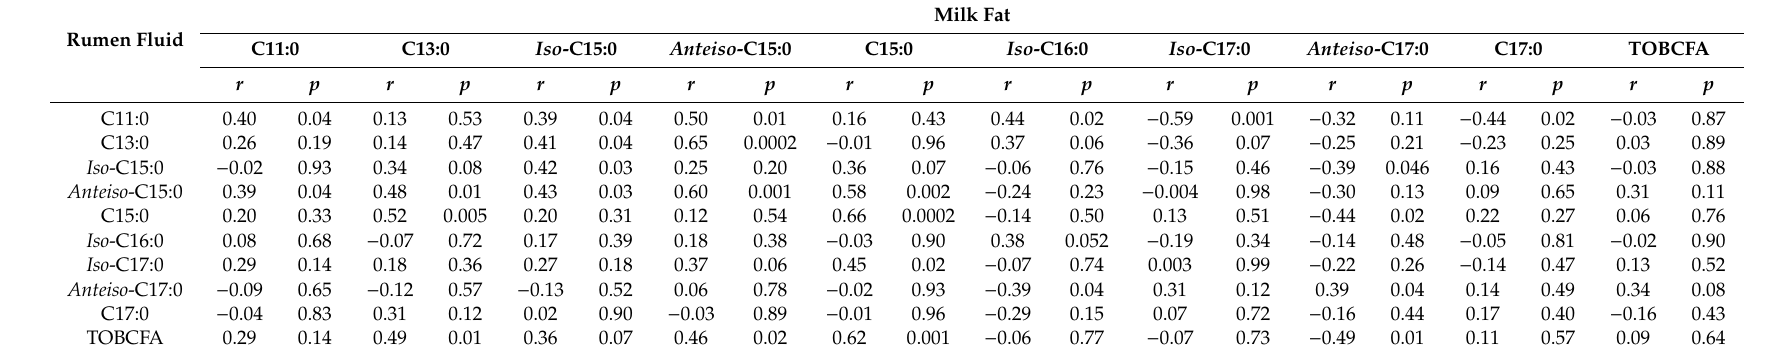
Table 4. Correlation between rumen and milk OBCFA of di ff erent milk